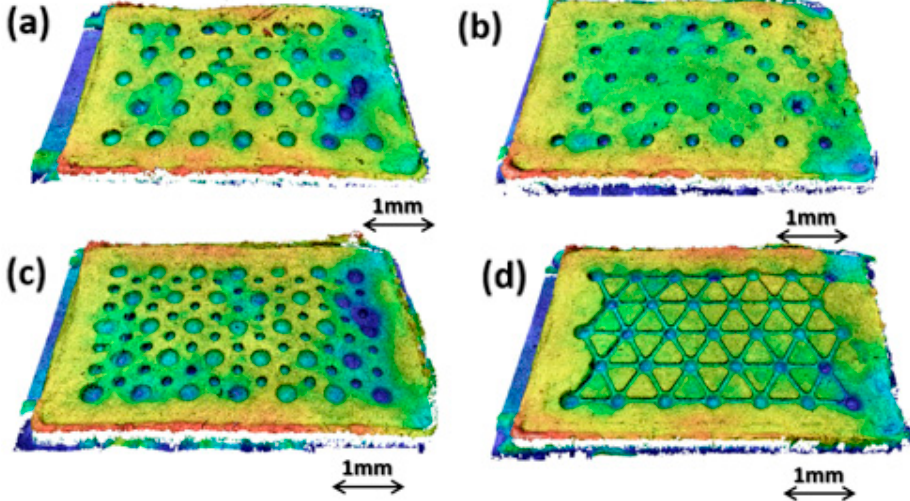
Figure 15. Isometric 3D view of the molded UHMWPE samples: HEX-300 ( a ); HEX-200 ( b ); HEX-300-150 ( c ); HEX-300+CH ( d ).